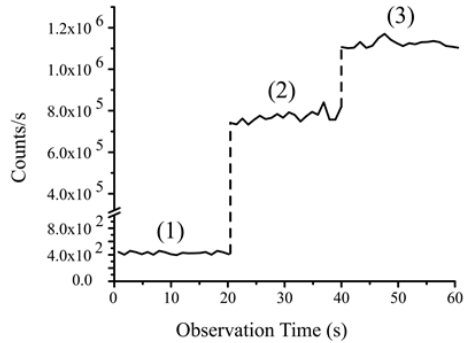
Figure 6. Photon count rate through an optical nanofiber (diameter 400 nm) in a Cs MOT setup. (1) MOT laser beams and magnetic fields are off; (2) MOT laser beams are on, magnetic fields are off; (3) MOT laser beans and magnetic fields are on. Reprinted with permission from [38]. Copyright 2007 Optical Society of